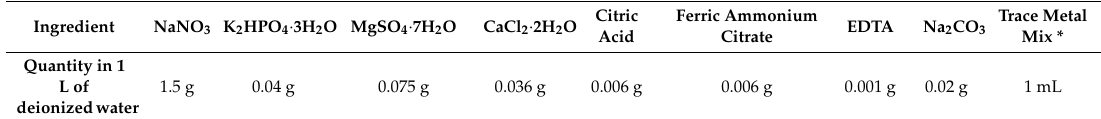
Table 1. Composition of BG-11 medium [18].